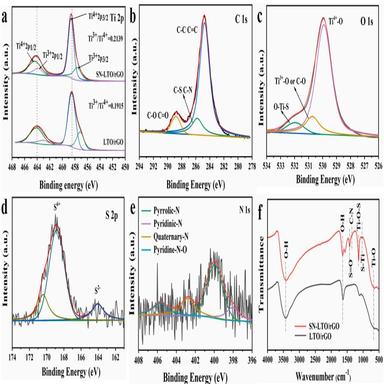
XPS high-spectra in SN-LTO/rGO of (a) Ti 2p, (b) C 1s, (c) O 1s, (d) S 2p, (e) N 1s; (f) FT-IR spectra of LTO/rGO and SN-LTO/rGO.